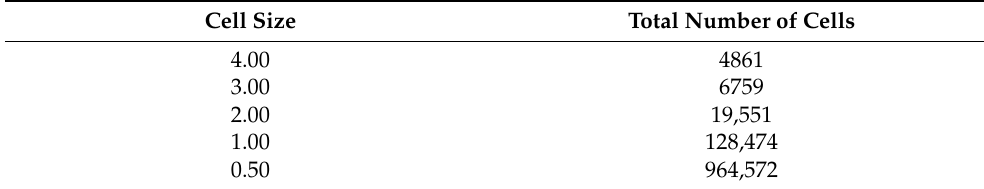
Table 3. Number of cells for each cell size.